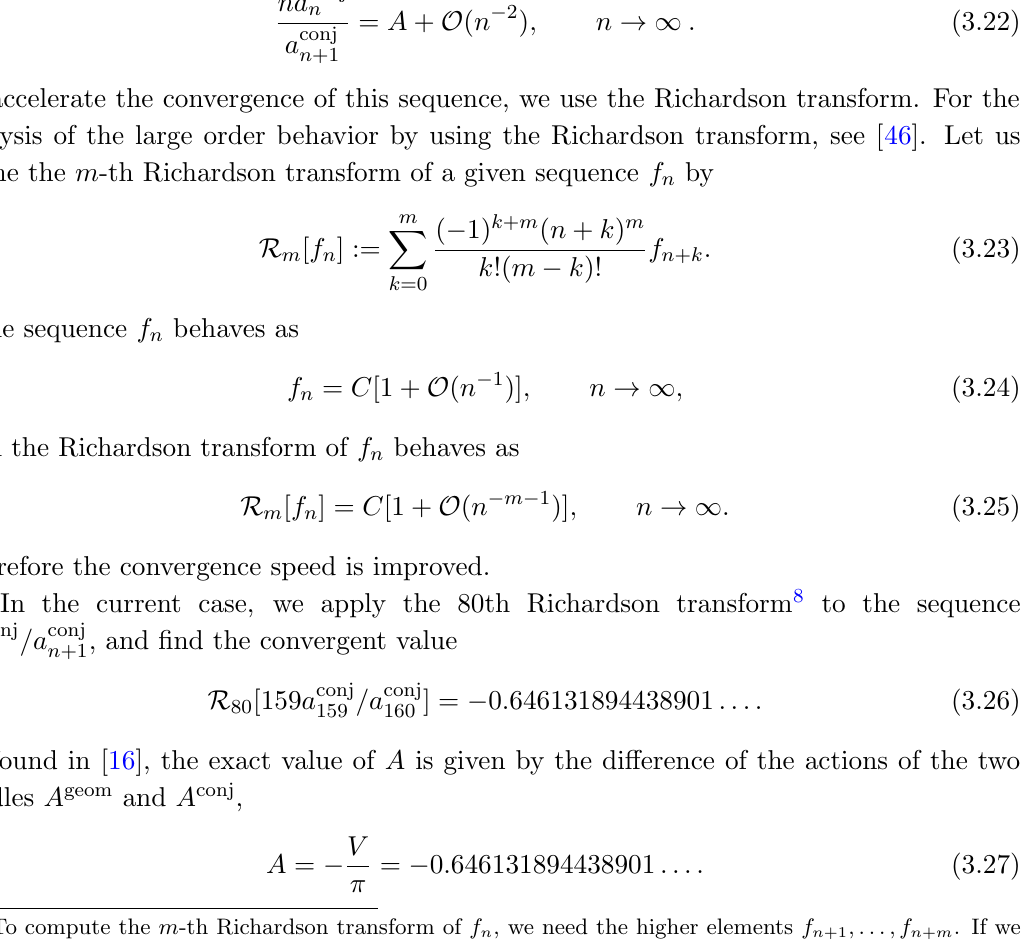
( k ) does not recover the S -duality, while the imaginary part